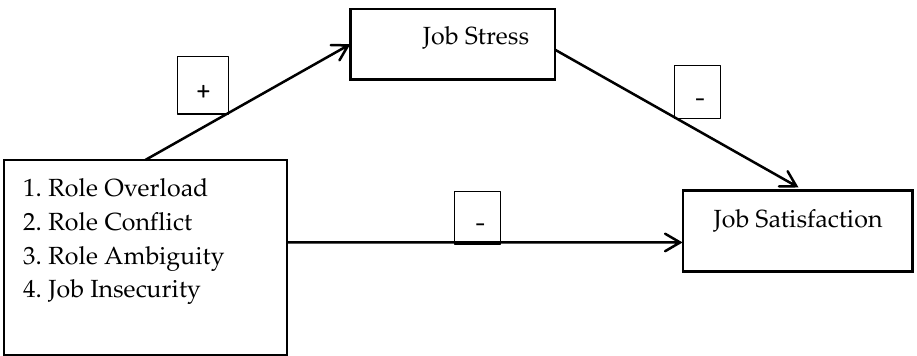
Figure 1. Empirical model of the study. Figure 1: Empirical model of the study